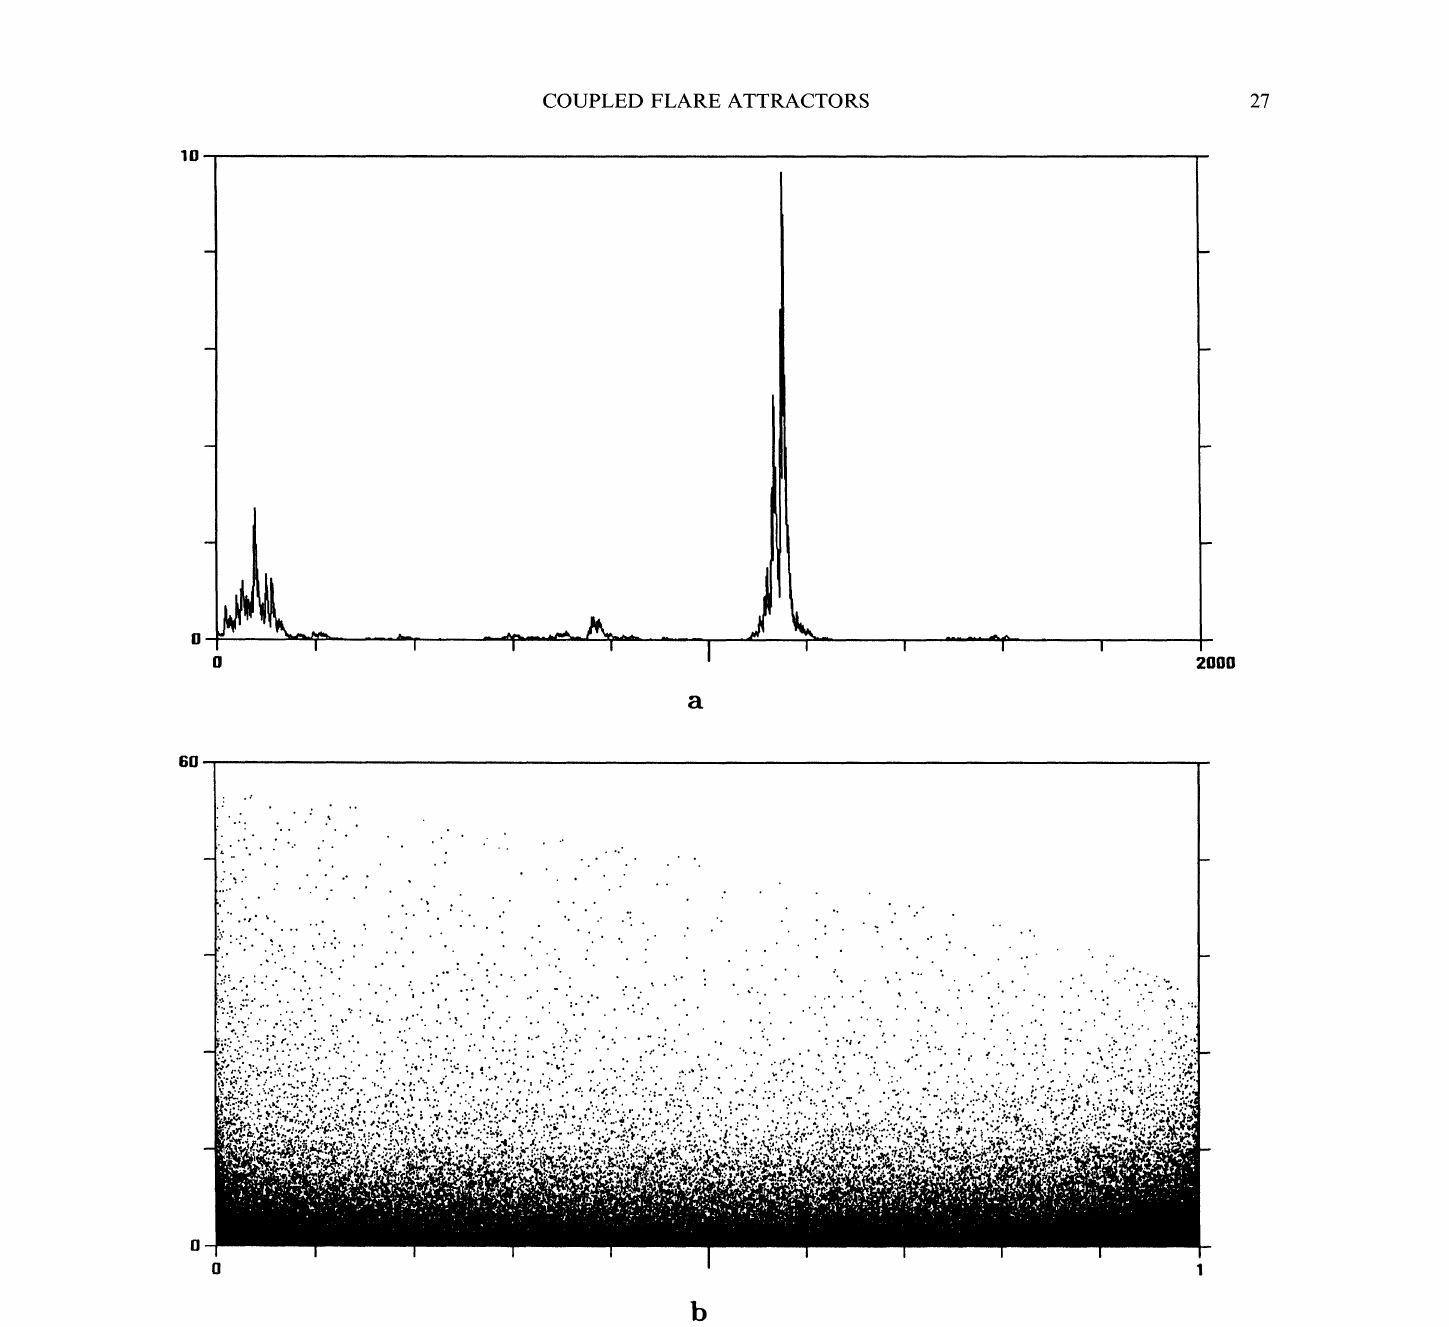
FIGURE 2 A simple flare attractor based on the logistic difference equation: Numerical simulation of Eq. (1). (a) Time plot of the flaring variable, b. Hereby successive points were connected by a straight line segment. (b) Side view (x, b plot). Parameter values: threshold=0.7; =0.01. Initial conditions: xl--0,